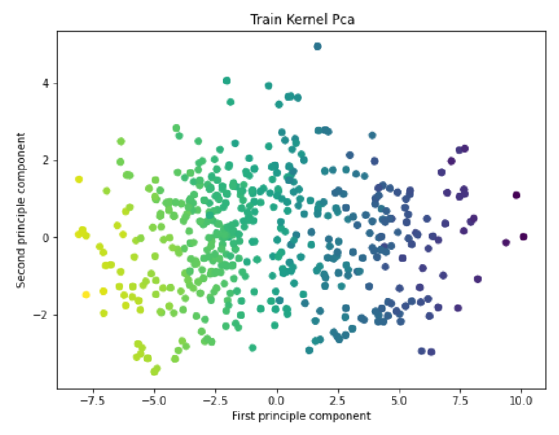
Figure 8. Train Kernel